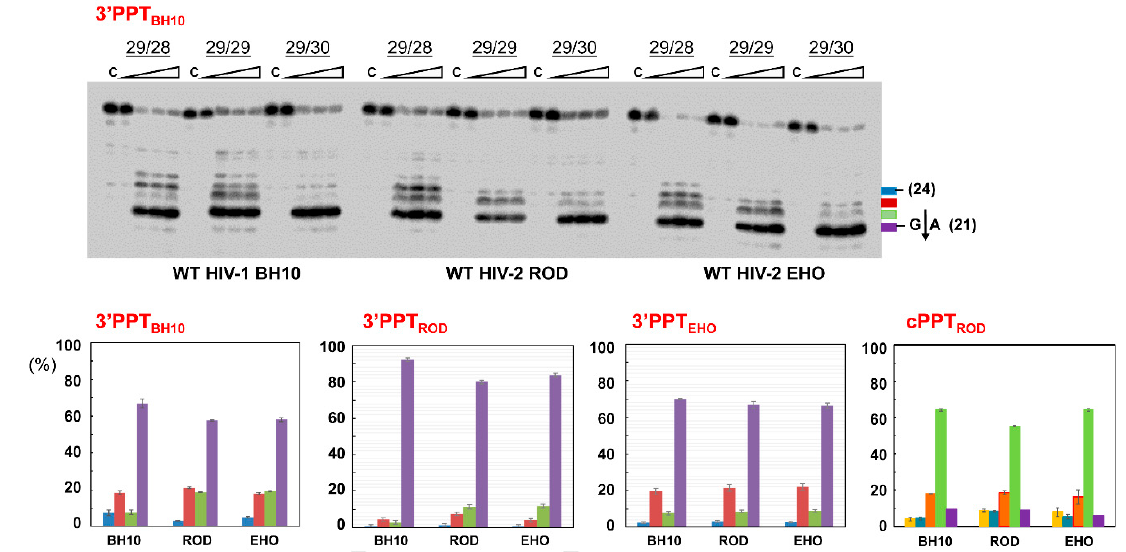
Figure 6. RNase H cleavage specificity of WT HIV-1 BH10 , HIV-2 ROD and HIV-2 EHO RTs on representative PPTs. Reactions were carried out in the presence of RT and template-primer at concentrations of 125 nM and 25 nM, respectively. RT and template-primer were pre-incubated for 5 min at 37 °C, and aliquots were withdrawn at 0, 20, 40 and 180 s after the addition of magnesium and heparin. Lane C shows control experiments including heparin in the pre-incubation buffer. Numbers above indicate the template-primer used in each experiment: 29/28, 29/29 and 29/30 for 29RNA/28DNA, 29RNA/29DNA and 29RNA/30DNA hybrids, respectively (see Figure 4A for sequence details). The 21-nucleotide products that derive from cleavage at the PPT/U3 cleavage site when using the 3’PPT BH10 complexes are indicated with an arrow in the right side of the gel. Histograms below indicate the proportions of hydrolysis products obtained with the three WT RTs and 29RNA/28DNA complexes representing the indicated PPTs (see Figure 4A and Supplementary Figure S1 for sequence details). Bar colors indicate the size of the oligonucleotide products: 21 (purple), 22 (green), 23 (red), 24 (blue) and 25 (yellow). Represented values were obtained from at least three independent determinations.